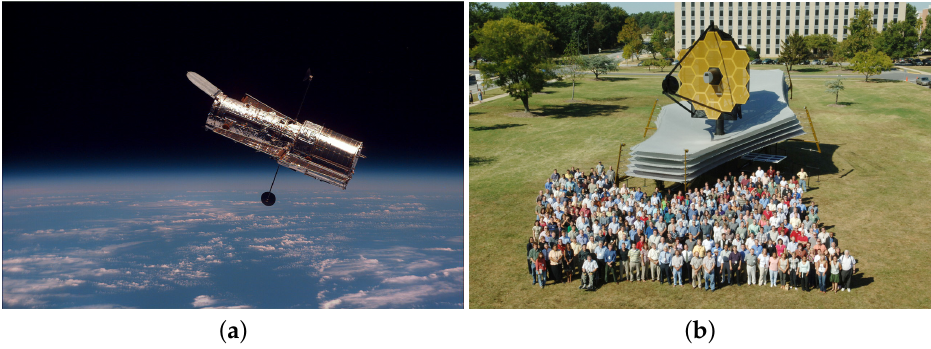
Figure 3. ( a ) Hubble as seen from the Space Shuttle Discovery during its second servicing mission [4]; and ( b ) the James Webb Space Telescope full-scale model assembled on the lawn at Goddard Space Flight Center with the JWST team [14].